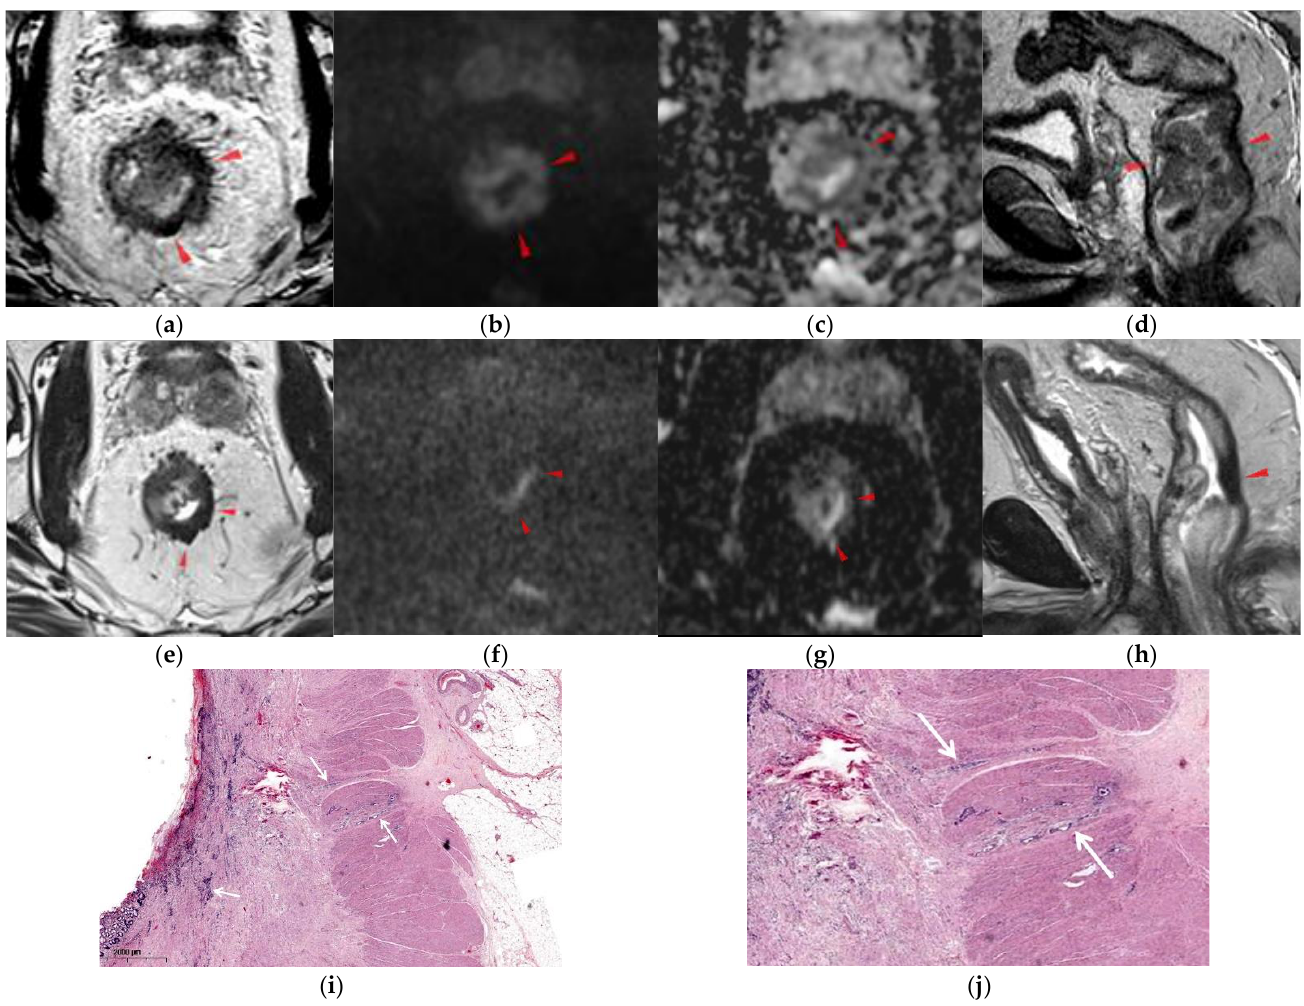
Figure 3. A 58-year-old male patient, initially staged T3cCRM-N+N1c-EMVI+, with near-complete response at restaging MRI and histopathology (yp T3N0, modified Ryan score 1). ( a – d ) Staging MRI showing low and middle rectal tumor (red arrowheads): axial T2WI HR ( a ), DWI ( b ), ADC ( c ), sagittal T2WI ( d ). ( e – h ) Restaging MRI after nCRT: axial T2WI HR ( e ), DWI ( f ), ADC ( g ) sagittal T2WI ( h ) showing marked tumor reduction with pronounced hypointense wall thickening between 2–8 o’clock, without isointense signal on T2WI (score 1, SSS-). The high signal on b1000 DW image ( f ), also high on ADC ( g ), was interpreted as T2 shine-through effects from fluid in the rectal lumen, indicating no clear areas of residual hyperintense signal on b ≥ 1000 (score 1). ( i , j ) hematoxylin and eosin-stained 4- µ m cut slices through the tumor scar illustrate denudated mucosa, dense fibrosis in the submucosa, muscularis propria and in the perirectal fat, with rare small groups of cancer cells in muscularis propria and submucosa (white arrows).